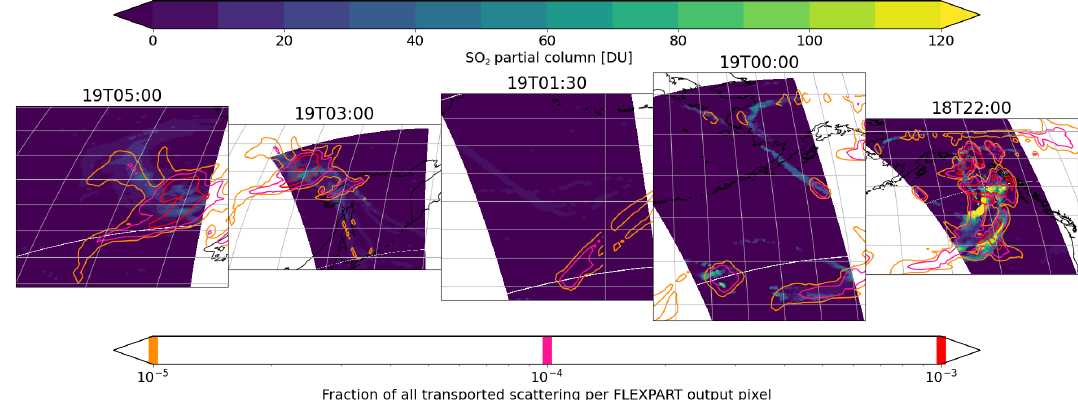
Figure 6. Overview of the transport of vertical profiles from the CALIOP swaths to the time of the AIRS swaths from Fig. 2. The figures are zoomed in on the areas of the most SO 2 for ease of comparison. To get a flat horizontal mapping of the transported CALIOP swaths, the combined profiles were integrated vertically. Percentages of SO 2 mass outside the 10 − 5 contour compared to the total SO 2 mass are 0.5% (18T22:00), 0.8% (19T00:00), 0.7% (19T01:30), 0.7% (19T03:00), and 0.6%